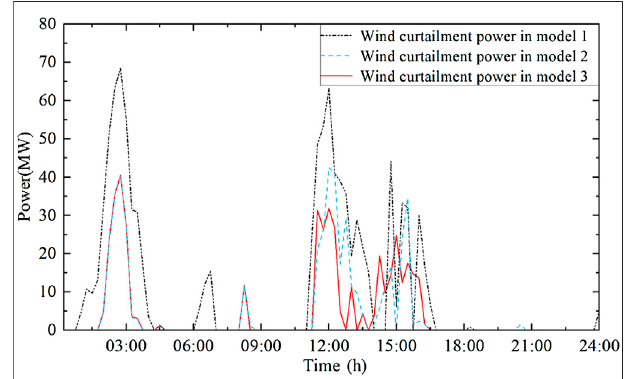
FIGURE 6 | Power balance of the ESS and CSP plant active power with model 2 and model 3